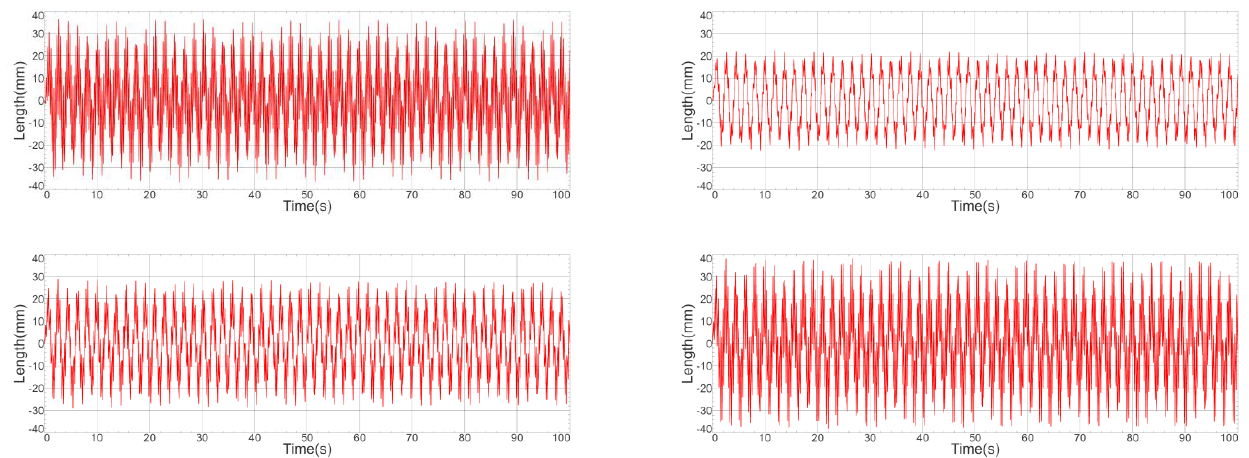
Figure 12. The displacement in time depending on the story m1, m2, m3 and m4 with use of the vibration reducing force determined in accordance with method I using the PLM Siemens NX 12 software.